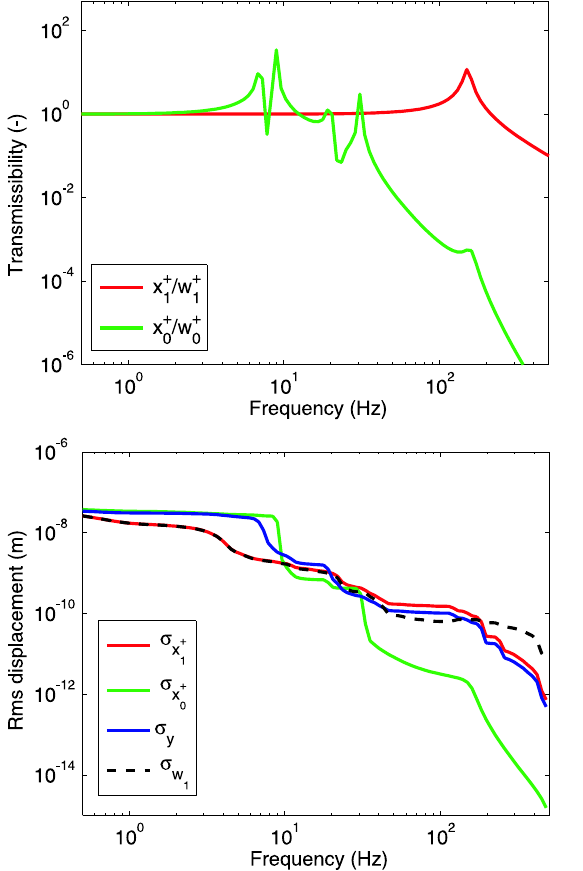
off.FIG. 14. Transfer functions and integrated rms values of the quadrupoles response for f